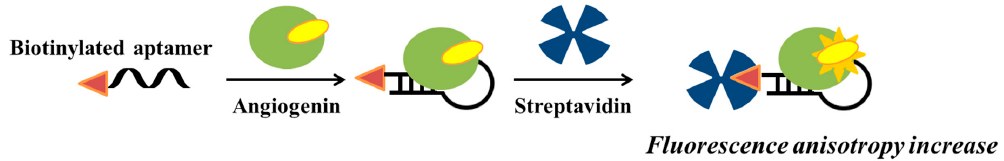
Figure 15. Schematic representation of angiogenin detection strategy based on streptavidin-triggered amplified fluorescence polarization